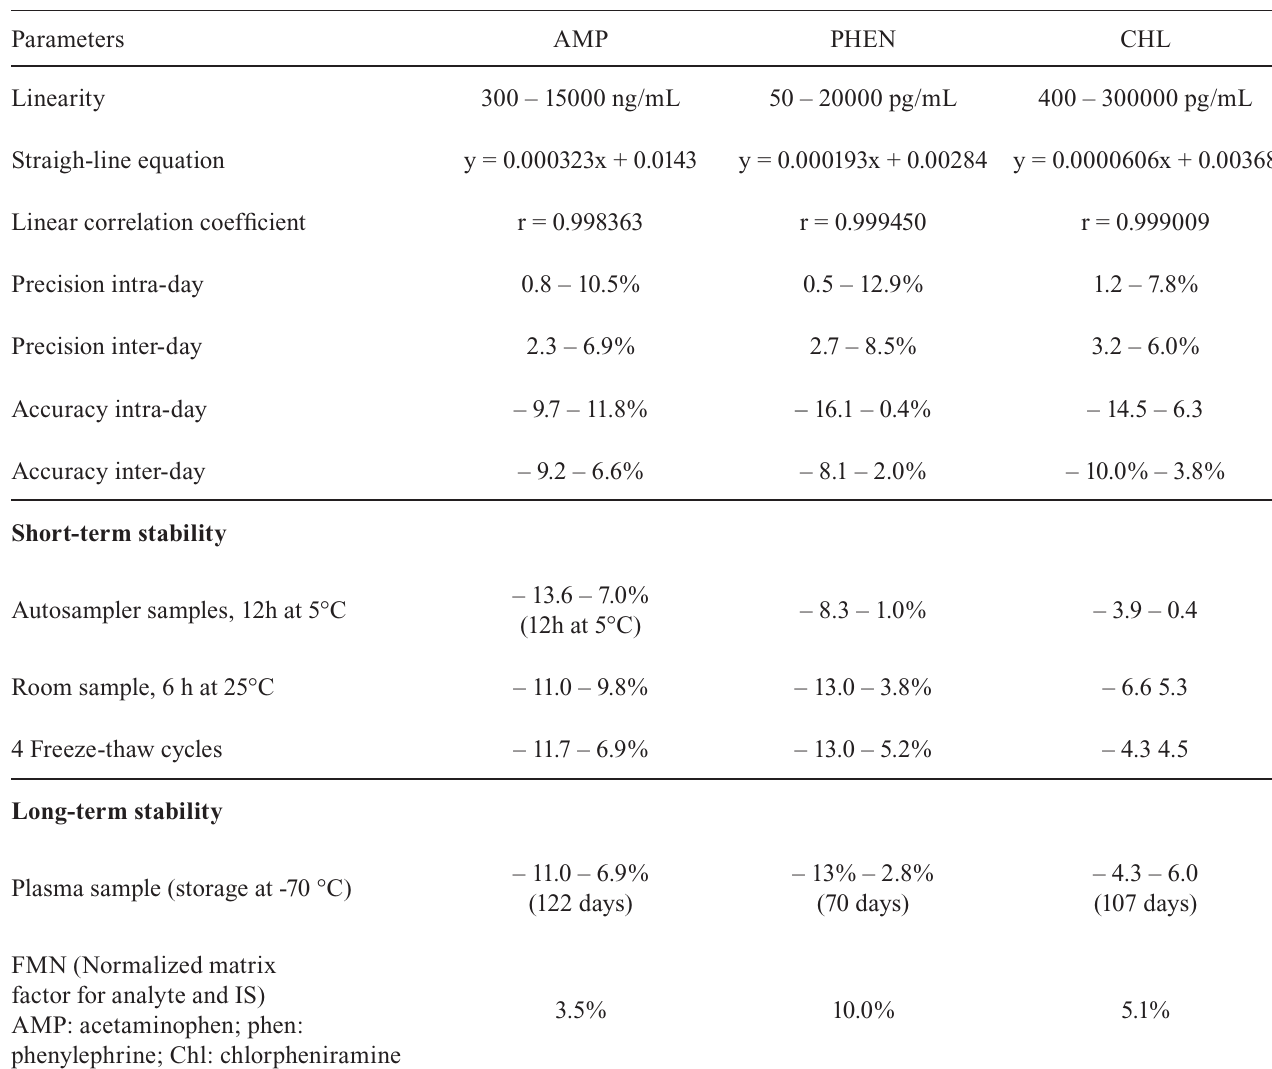
TABLE II - Parameters obtained in validations of the bioanalytical methodos for determination acetaminophen, phenylephrine and